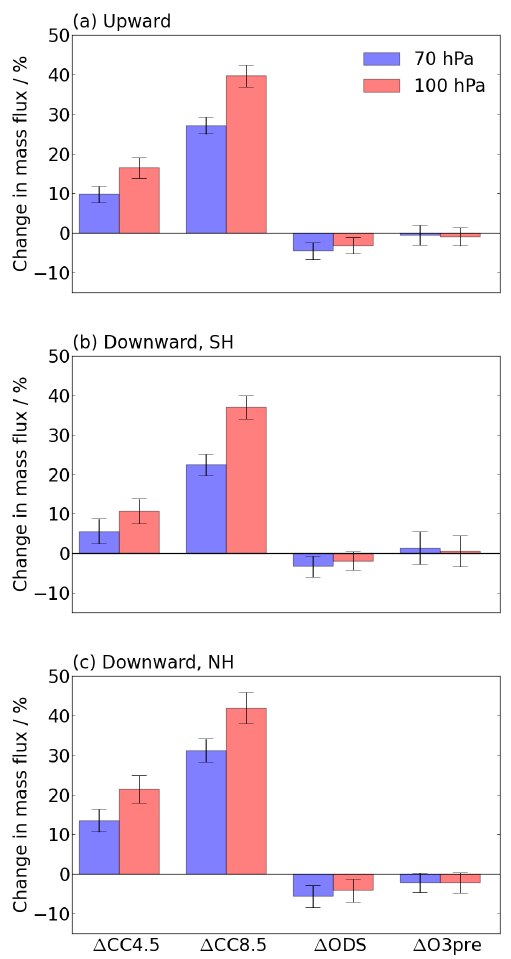
Figure 7. Changes in total (a) upward (b) downward (SH) and (c) downward (NH) mass fluxes at 70hPa (blue bars) and 100hPa (red bars) for the single-forcing experiments relative to Base. Er- ror bars indicate the 5–95% confidence interval, calculated as ± 1.96 times the standard error in the mean of the